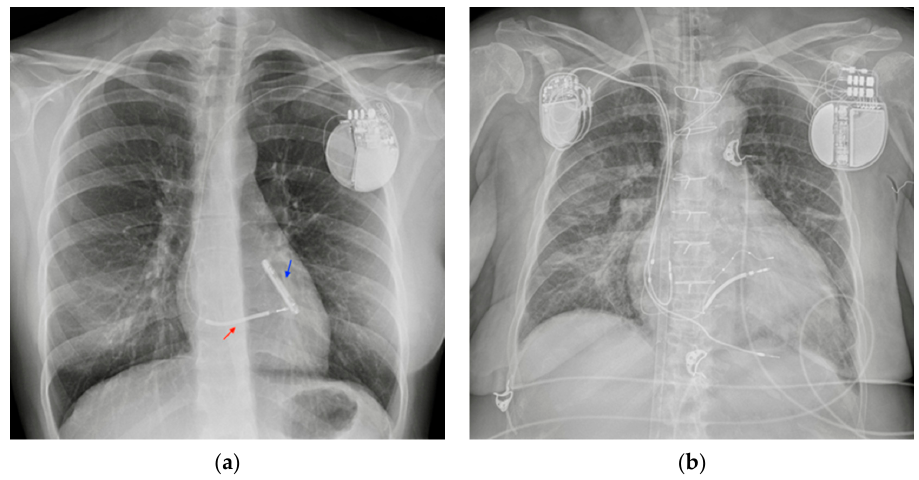
Figure 14. PM and AICD. ( a ) A normally inserted AICD. The thick coil can easily be seen at the end of the lead (red arrow). This patient also has an implantable loop recorder (blue arrow). ( b ) A patient with both a PM (right side) and an ICD–biventricular pacemaker combination (left side); also in the image, a right jugular CVC, an ETT and an extracorporeal membrane oxygenation (ECMO) cannula whose tip reaches the right atrium via the IVC (femoral access) (Table 4). Table 4. Cardiac devices’ most frequent CXR-detectable anomalies and complications.